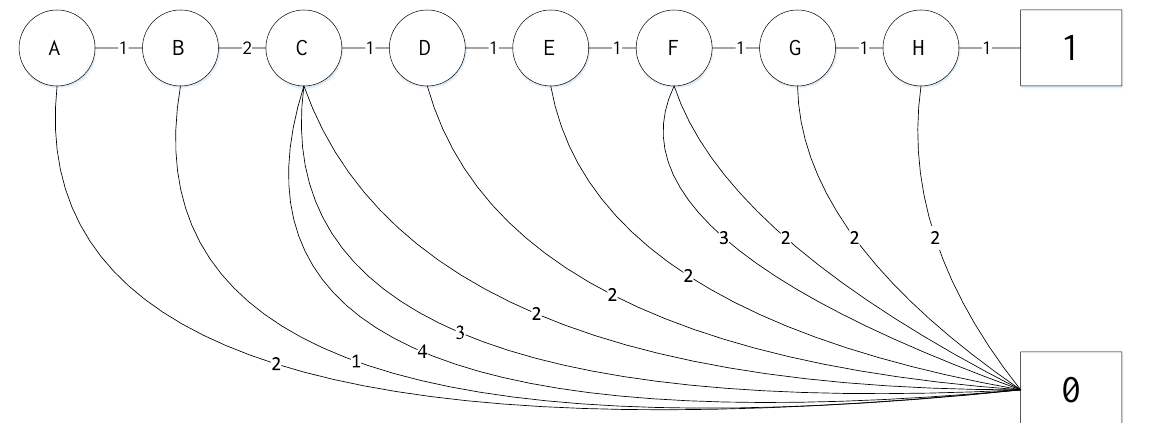
Figure 4 . The MDD of the bogie system in state